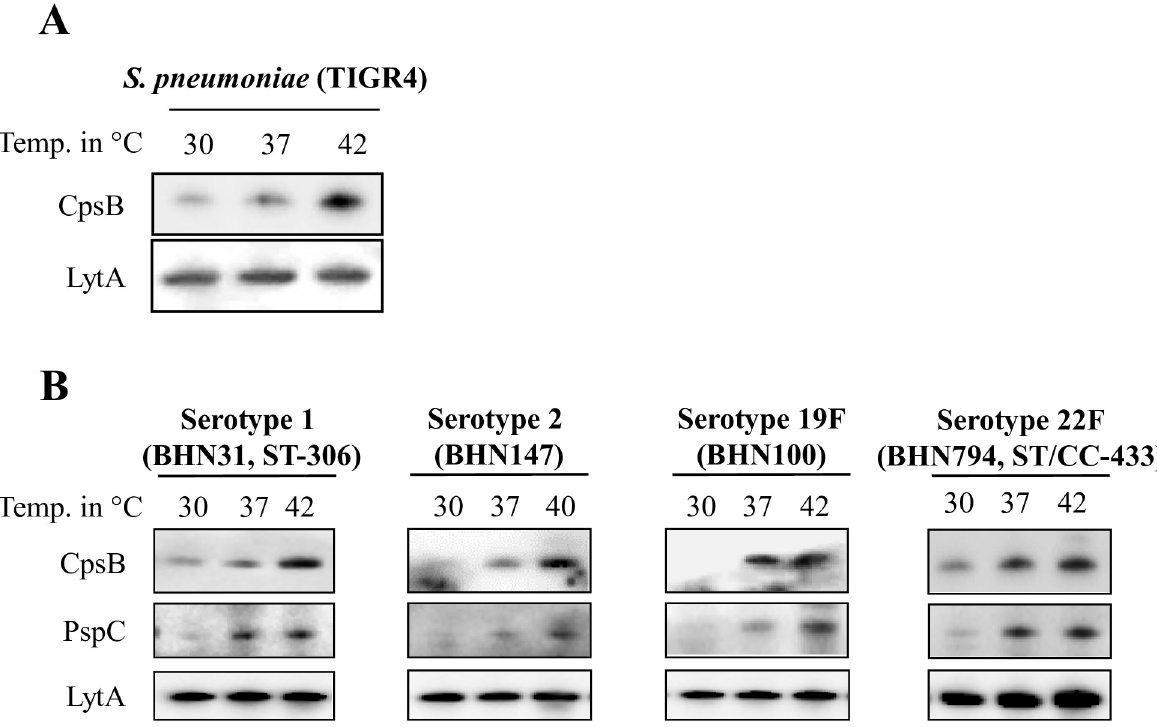
Fig 4. Clinical isolates of S . pneumoniae also possess thermosensing capability. (A) Thermoregulation of CpsB in S . pneumoniae TIGR4 as detected by western blot analysis. (B) Thermoregulation of CpsB and PspC, using western blot analyses, in clinical pneumococcal isolates of serotypes 1, 2 19F and 22F. LytA was used as a loading control for all panels.